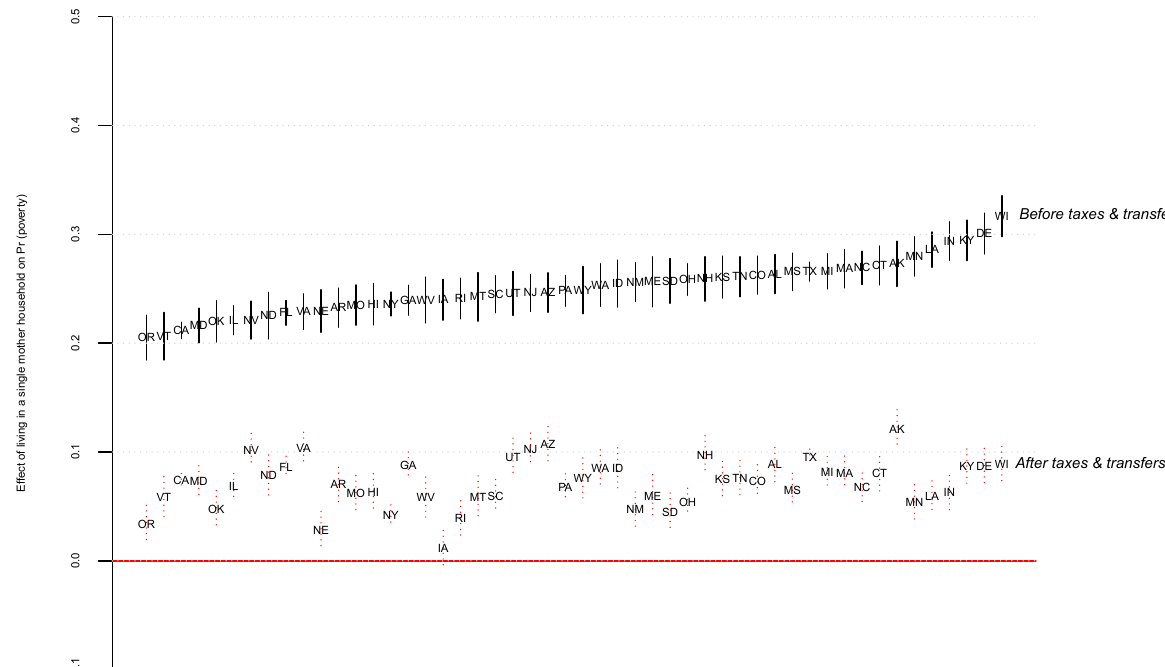
Figure 6: Single-mother penalty: effects of living in a single-mother household on Pr (poverty) before and after taxes and transfers (2012–2016 CPS). Adjustments for SNAP, SSI, and TANF underreporting were made using the Urban Institute Transfer Income Model (TRIM). Effects represent coefficients from varying slope linear probability models predicting SPM poverty. The nonvarying slopes in the model are year fixed effects and a control for metropolitan and/or nonmetropolitan status. States are indicated by their postal code